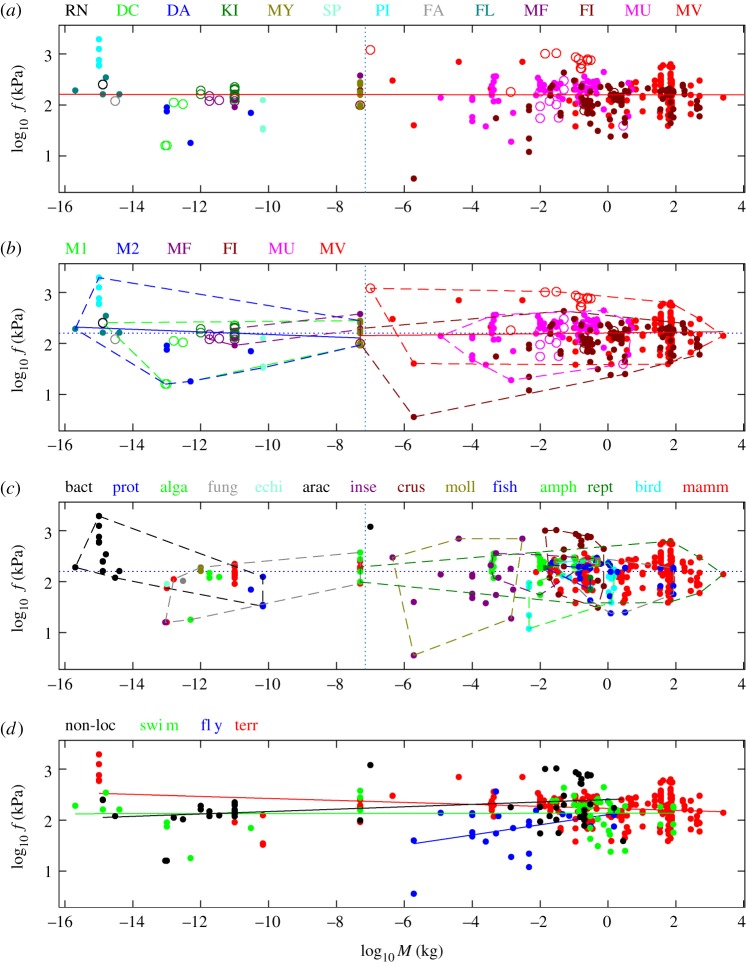
Log–log plot of specific tension versus cell or body mass. (a) Locomotors shown as points (n = 294) and non-locomotors as circles (n = 55). Regression line of all log10
f versus log10
M (solid red line, slope −5 × 10−4 not significantly different from zero, p = 0.90). Regression line of locomotors (slope −6 × 10−3 not significantly different from zero, p = 0.24) indistinguishable from red line, not shown (see the electronic supplementary material, table S7). Vertical dotted line: mass of cells on the left, of multicellular organisms on the right. Motor types: abbreviations and number of values per type as defined in figure 2. (b) Motor types: same abbreviations and numbers as in (a), except M1, single molecule (n = 27) and M2, molecular assembly (15 with pili). Symbols and colours of points as in (a). Points belonging to the same motor type located within the convex polygons shown. Regression lines of molecular motors (M1, M2 and MF, blue line on the left, slope −0.03 not significantly different from zero, p = 0.17) and non-molecular motors (FI, MU, MV, red line on the right, slope 7 × 10−3 not significantly different from zero, p = 0.47). For these and other regressions on motor types, see the electronic supplementary material, tables S7–S9. Horizontal dotted blue line is mean log10
f (kPa) = 2.2. Vertical dotted blue line as in (a). (c) Taxonomic groups: abbreviations and number of values per class as given in figure 3c, except for bacteria (n = 13 with pili). On the left side, polygons enclose motors from single cells (black) and from multicellular organisms (grey). For regressions on taxonomic groups, see the electronic supplementary material, tables S10 and S11. Horizontal and vertical dotted lines as in (b). (d) Motor functions: non-locomotory (n = 55), swimming (53), flying (25), terrestrial (216 with pili). Their respective regression lines are shown; their slopes s are significantly different from zero (non-loc, s = 0.02, p = 0.02; Fly, s = 0.1, p = 0.05; Terr, s = −0.02, p < 10−3) except Swim (s = 8 × 10−4, p = 0.93), see the electronic supplementary material, table S12. In all panels, the scale on the y-axis is 1.5 times larger than on the x-axis.